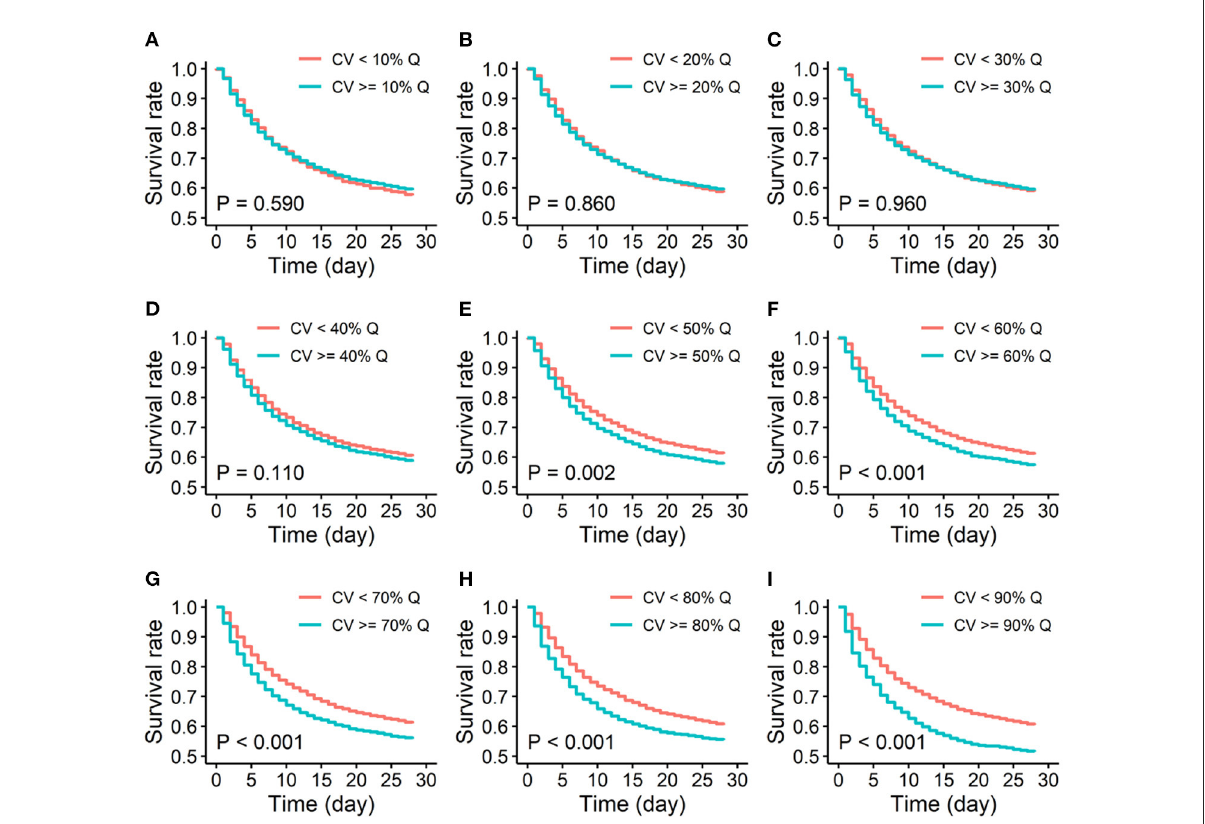
FIGURE3 Kaplan-Meier survival curves of low and high variability groups of 28-day mortality. (A-I) . Quantiles of MAP variability from 10% to 90% with 10% increasement each were considered to divide study participants into two groups: high variability ( ≥ each quantile of CV) and low variability ( < each quantile of CV). CV: coefficient of variation; % Q: % quantile of CV of MAP.